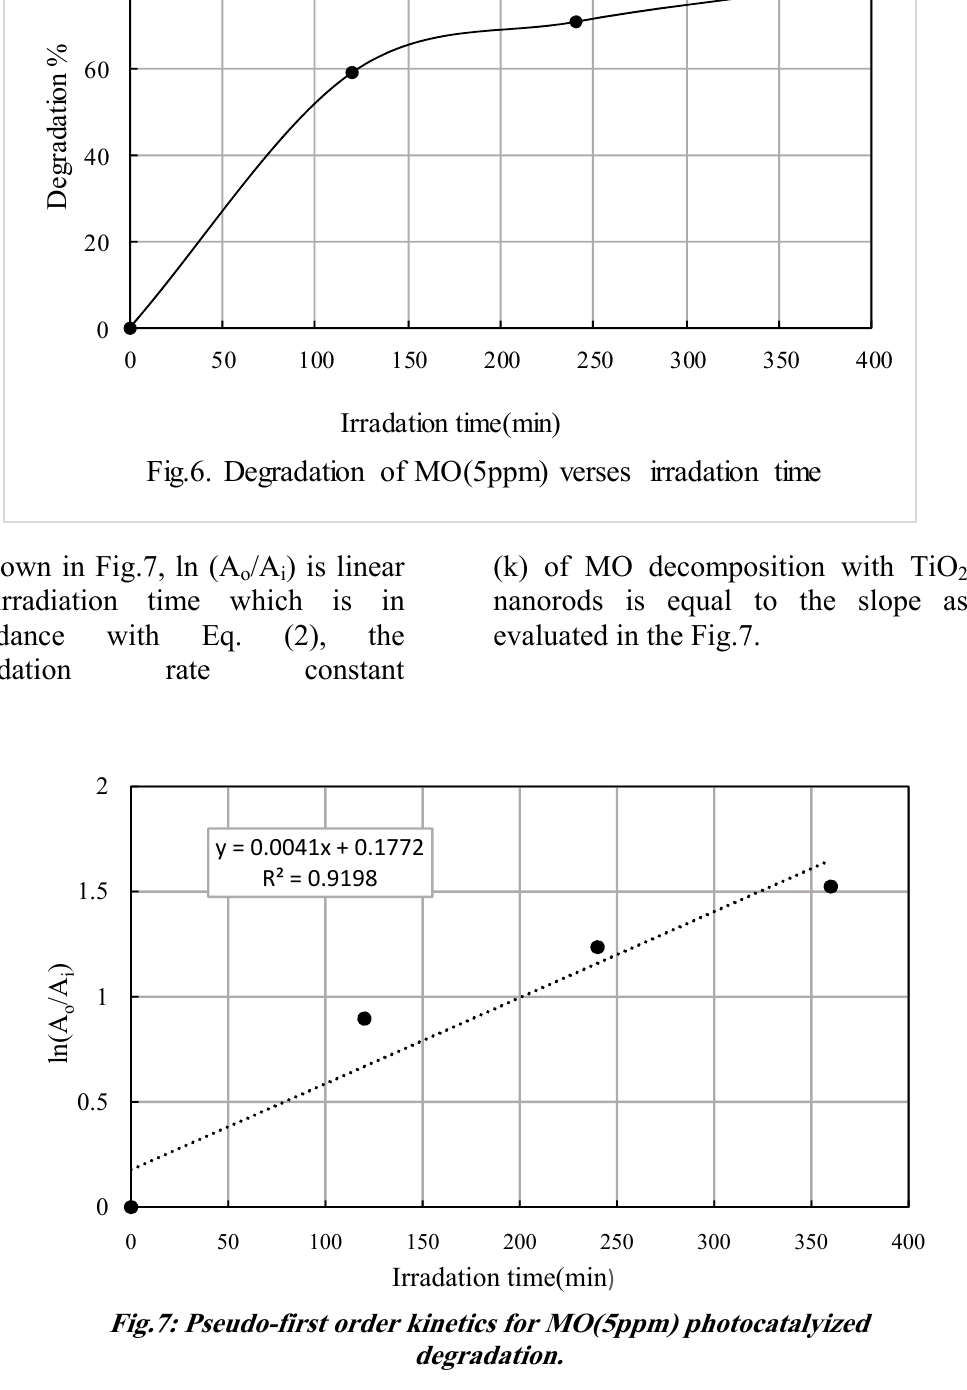
Fig.7: Pseudo-first order kinetics for MO(5ppm) photocatalyized